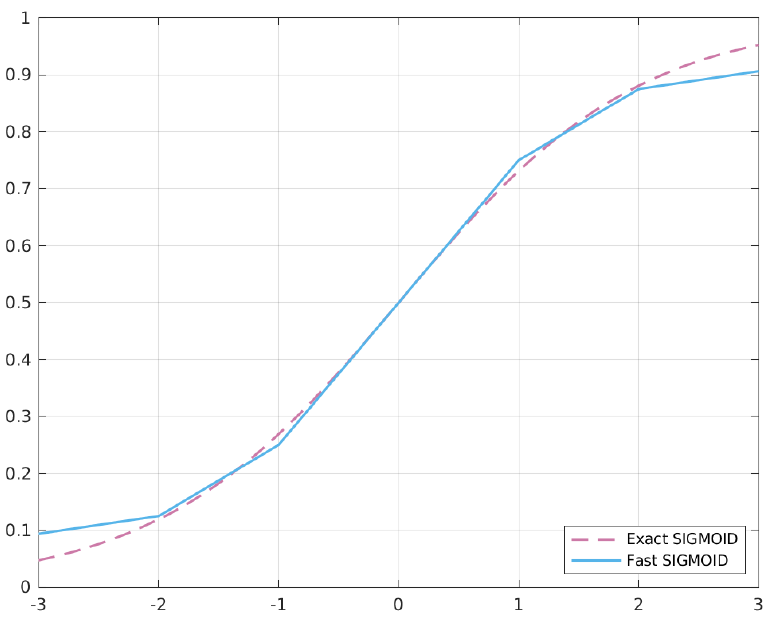
Figure 5. Accuracy comparison between the exact and approximated versions of the Sigmoid